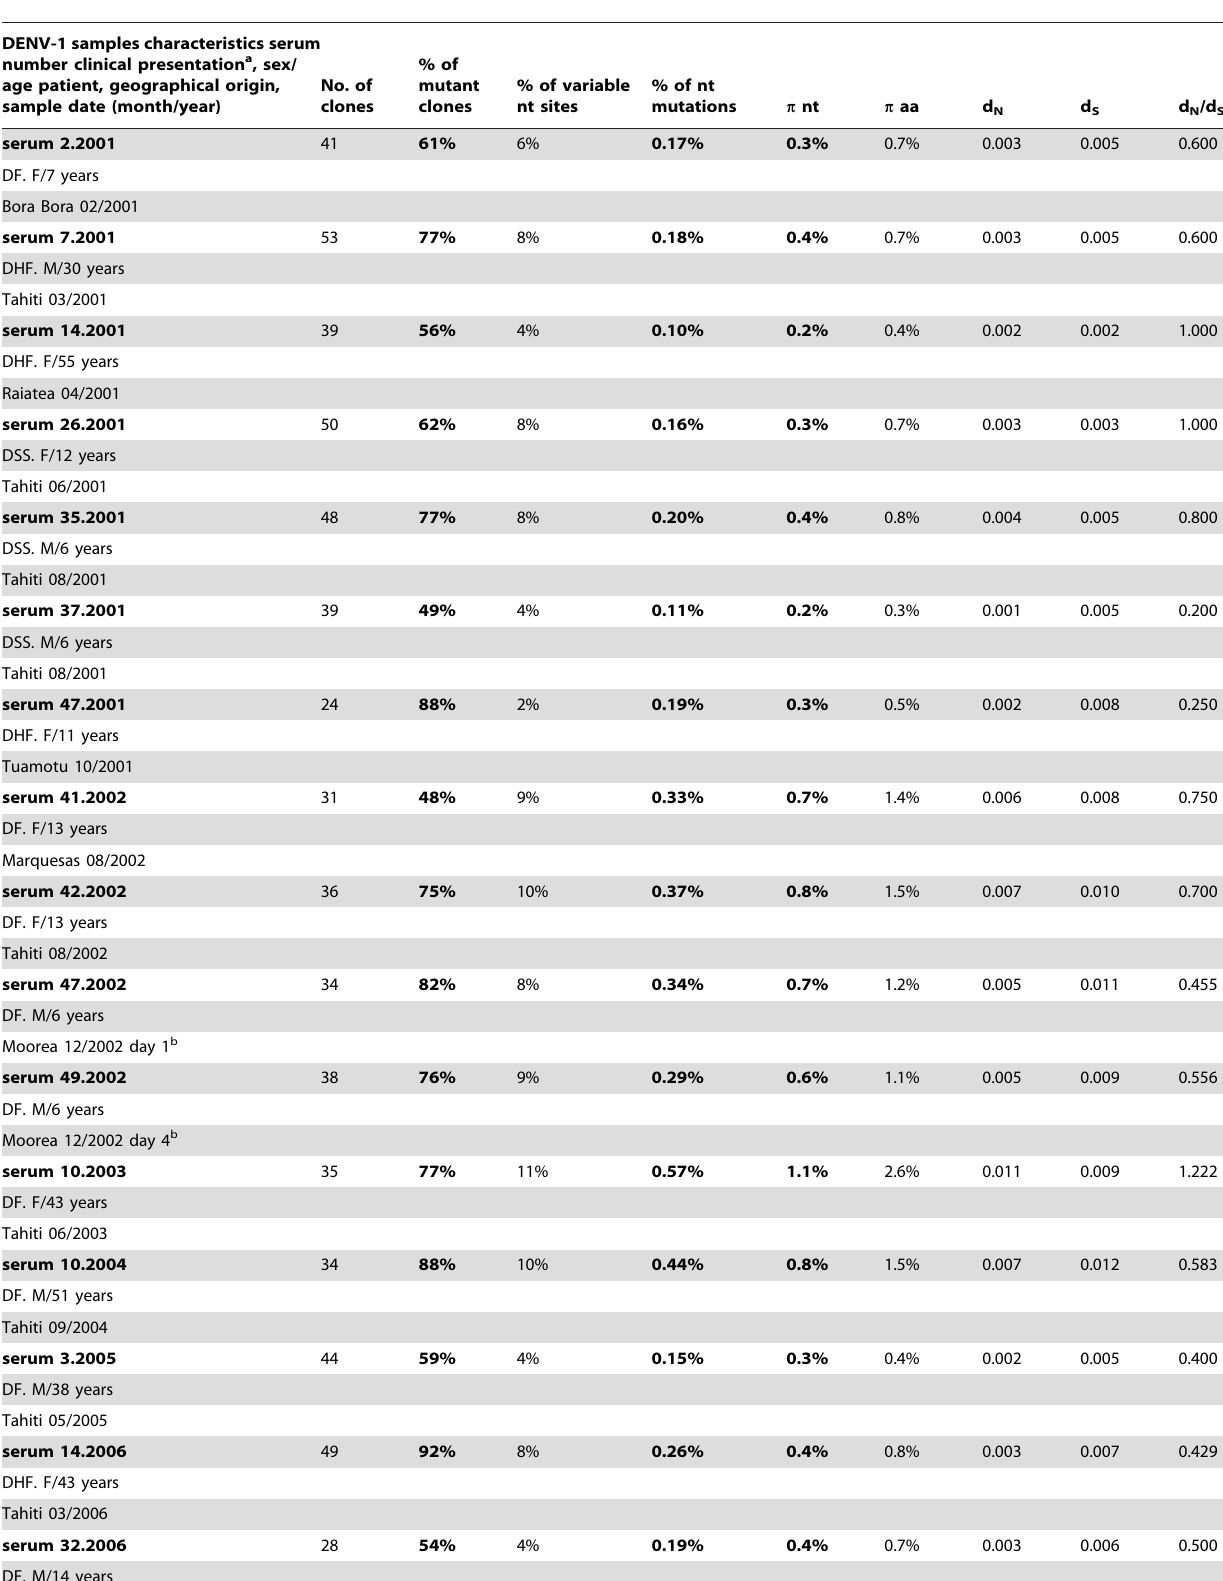
Table 4. Intra-host genetic diversity analysis of DENV-1 populations from 17 sera of patients infected in FP between 2001 and 2006.